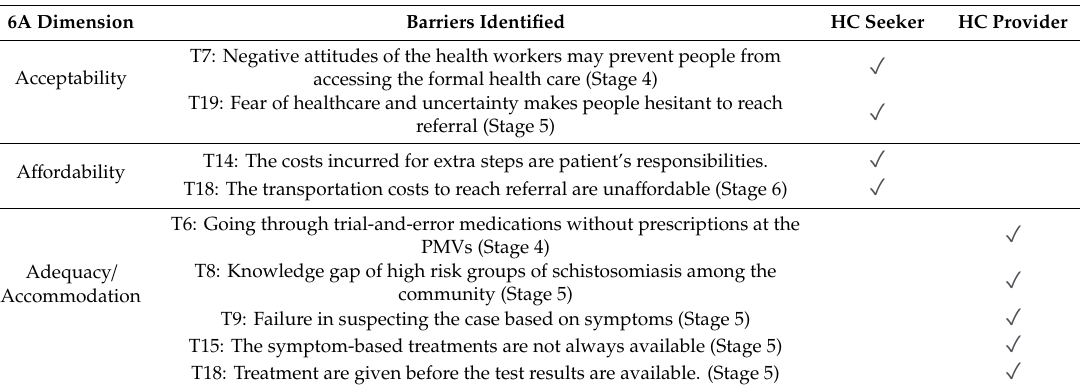
T15: The symptom-based treatments are not always available (Stage 5) ✓ T18: Treatment are given before the test results are available. (Stage 5) ✓ 1 Checkmark ✓ indicates from which perspective the barrier is found.